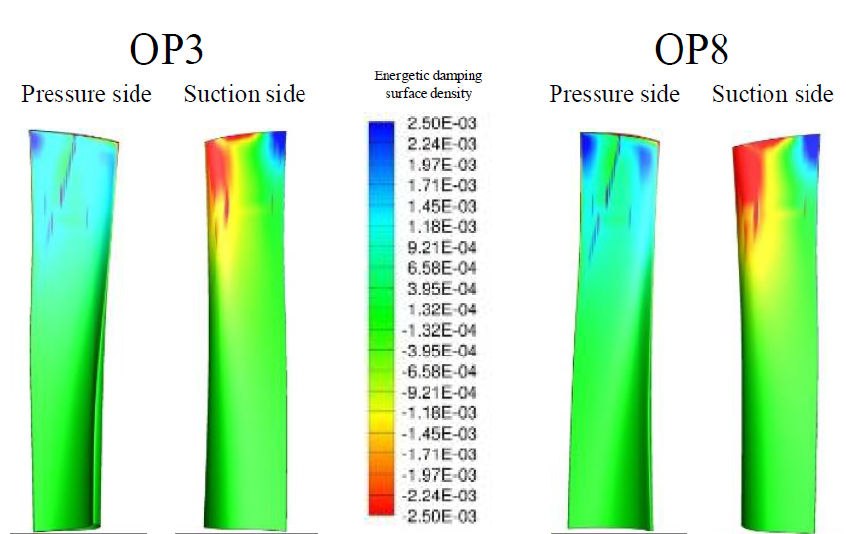
Figure 14. Energetic damping surface density for first mode shape, ND = 20 backward traveling wave, in OP3 and